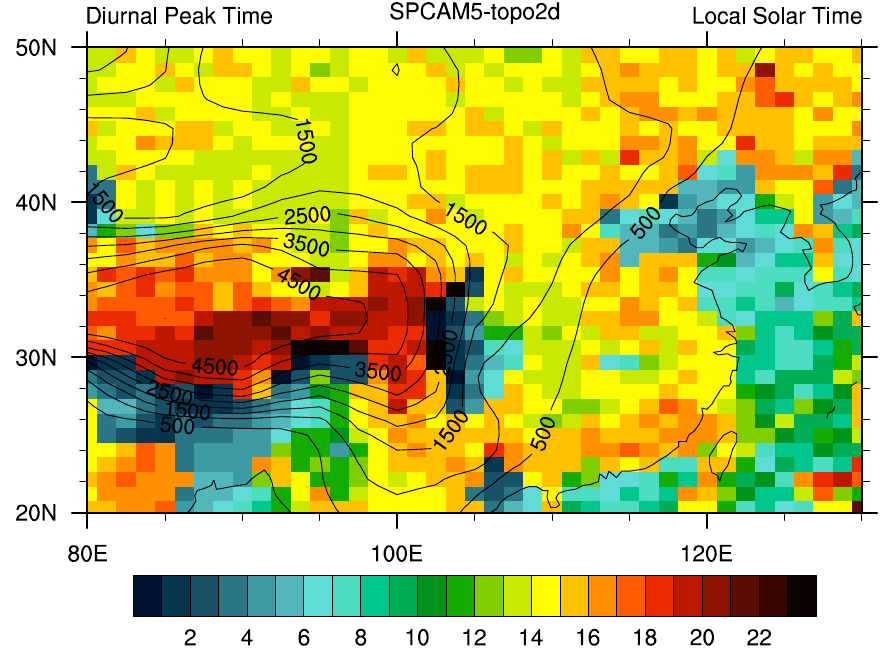
Figure 7. The peak time (local solar time) of rainfall over continental East Asia in SPCAM5-topo2d; the topography is contoured with thin black lines.